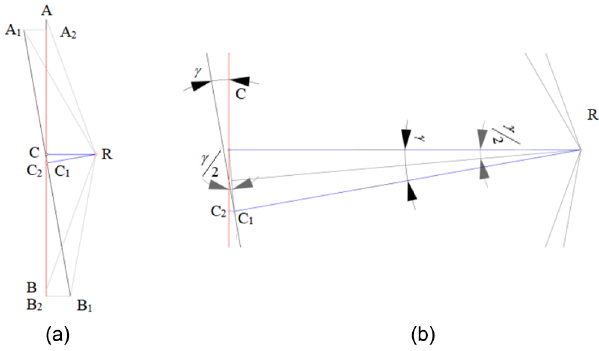
Fig. 16. Schematic of the translational deviation and calculation of the photographic data.